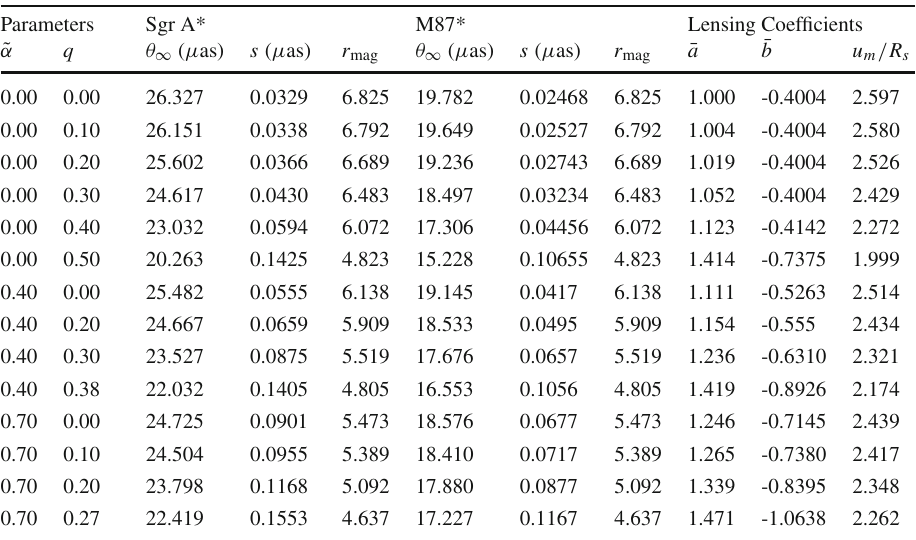
Table 1 Estimates for lensing observables and strong lensing coefficients for the supermassive black holes Sgr A* an M87* for different values of q and ˜ α